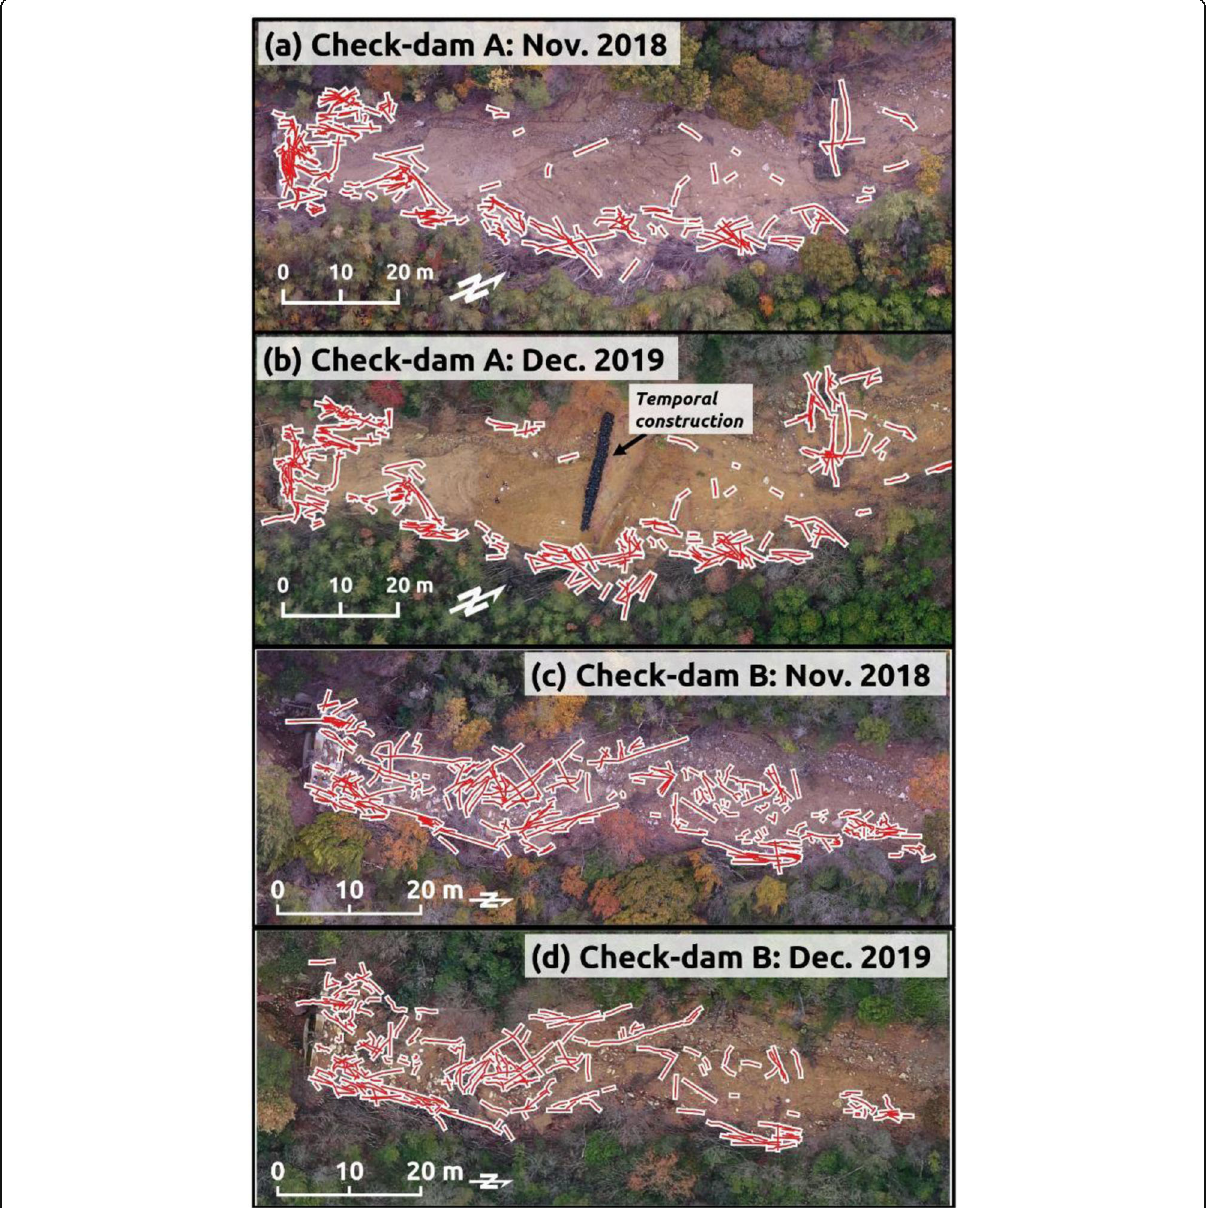
Fig. 11 Spatial distribution of extracted wood pieces at the broadleaf forest (BF) site: a check dam A on November 16, 2018, b check dam A on December 25, 2019, c check dam B on November 16, 2018, and d check-dam B on December 25,